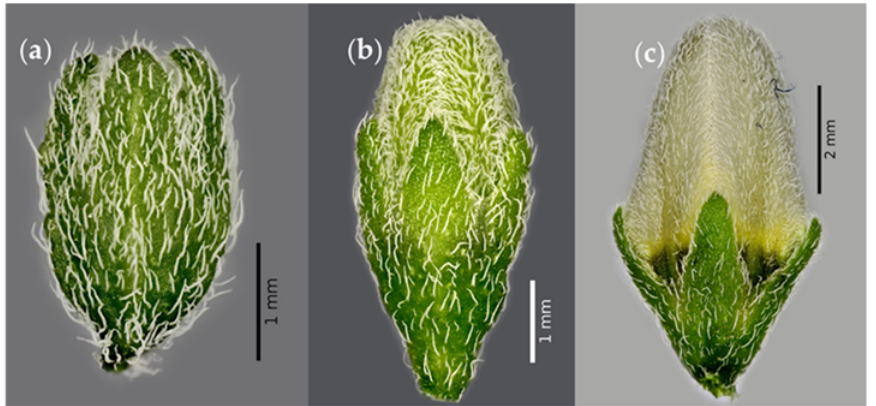
Figure 9. Flower buds of slender nightshade plants ( Solanum nigrescens ) at 5 ( a ), 20 ( b ), and 100% ( c ) open. Photos by Jorge Manuel Valdez-Carrasco.